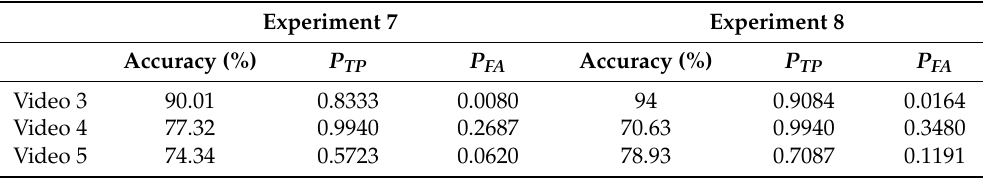
Table 6. Classification results for the second dataset at 1920 × 1080 and 3840 × 2160 resolutions (Experiments 7 and